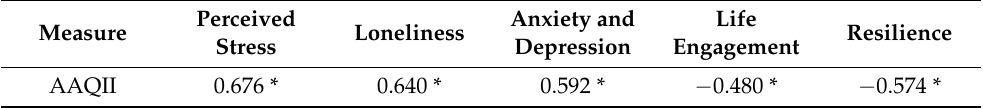
Table 4. Correlation matrix between AAQ-II scores and other psychological health-related